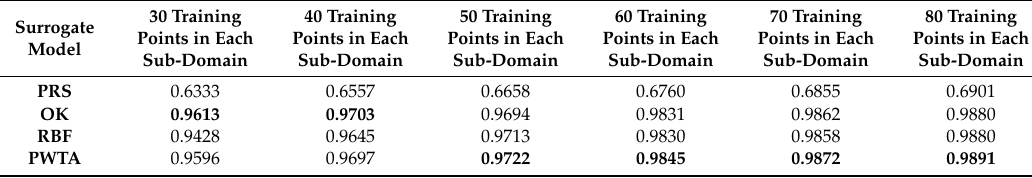
Table 4. Comparisons of R 2 for di ff erent surrogates in the global domain under di ff erent training sample sizes.